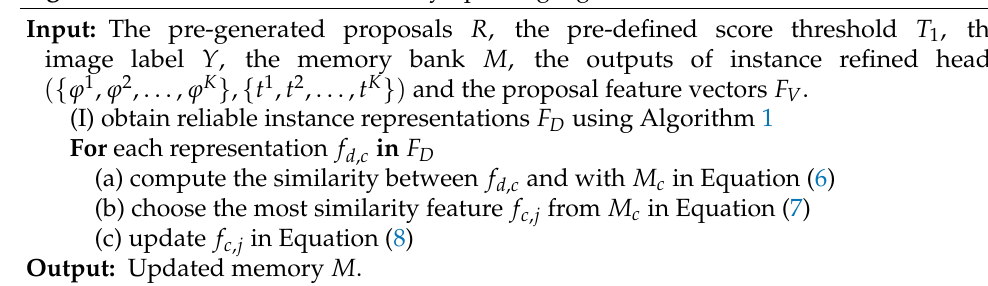
Algorithm 2 Instance-diverse memory updating